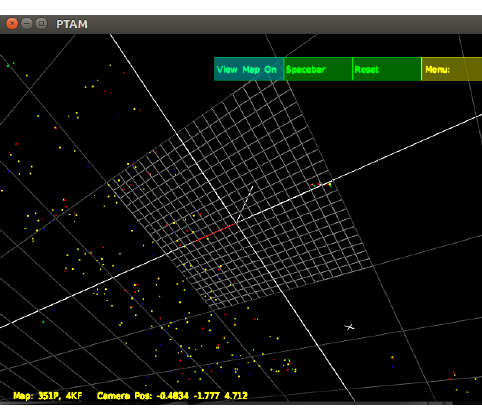
Figure 10. Generated Pointcloudby